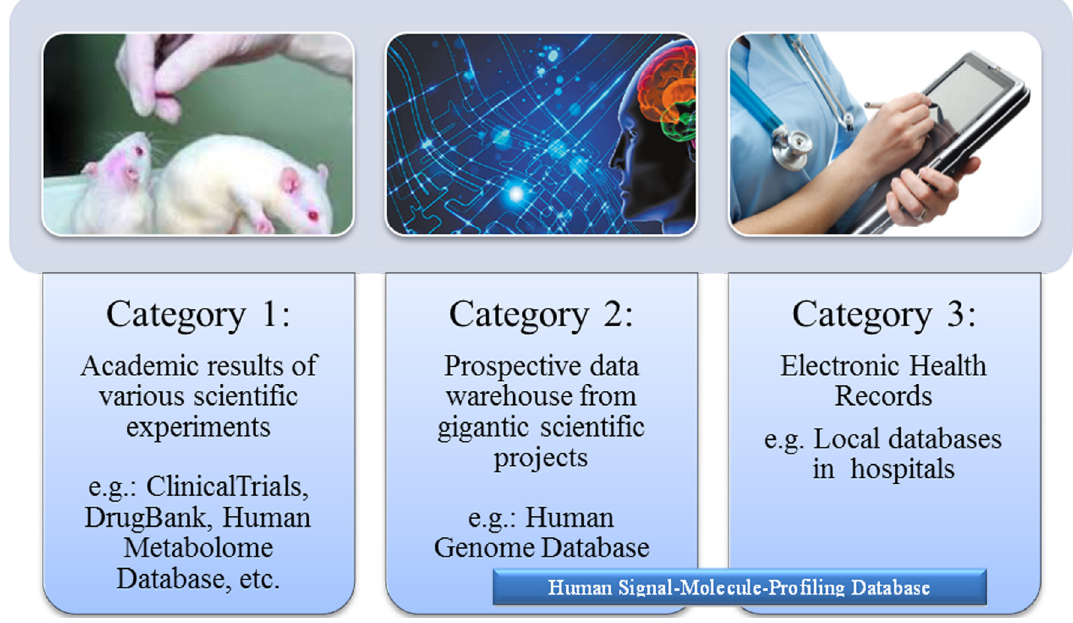
Figure 1. Three categories of current biomedical databases. The current